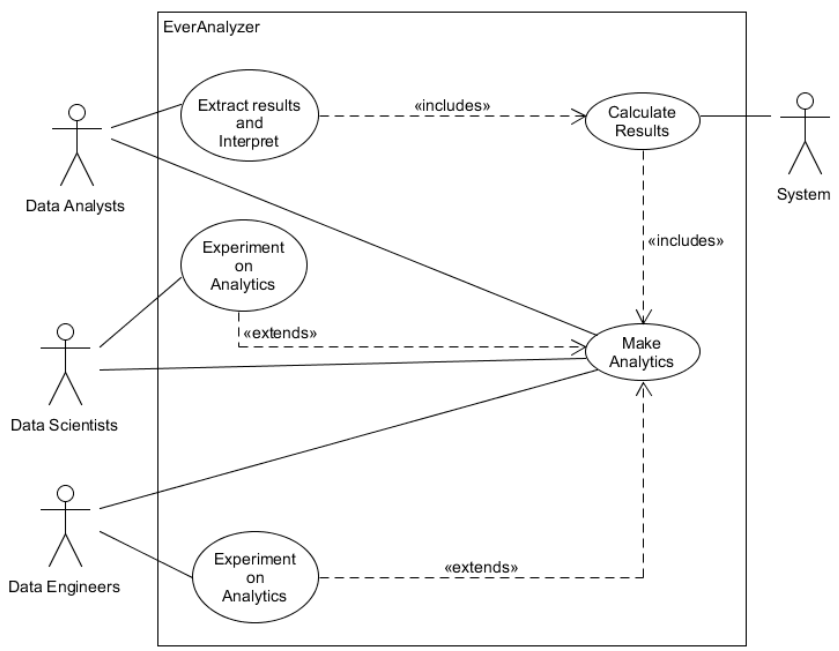
Figure 6. Use Case diagram of EverAnalyzer users.